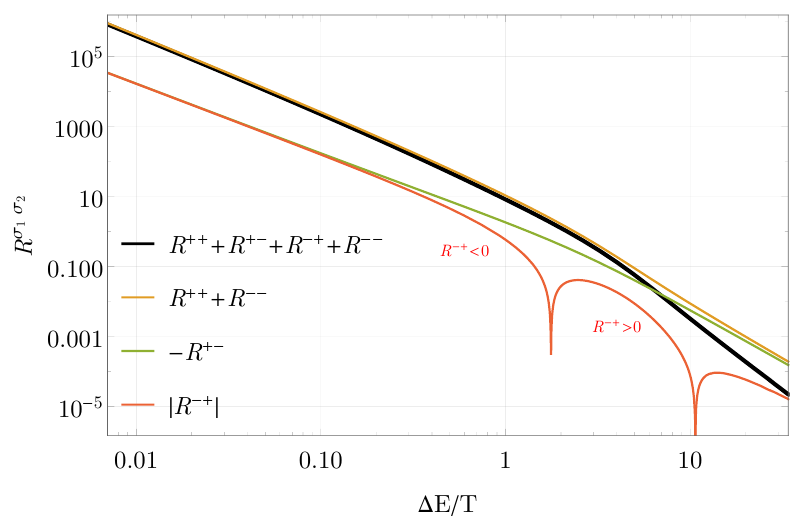
Figure 14 . The plot shows the individual R (cid:27) 1 (cid:27) 2 functions and their dependence on (cid:1) E=T . abundance computation e(cid:14)cient, since one can tabulate the sum over all these functions in advance depending on a single